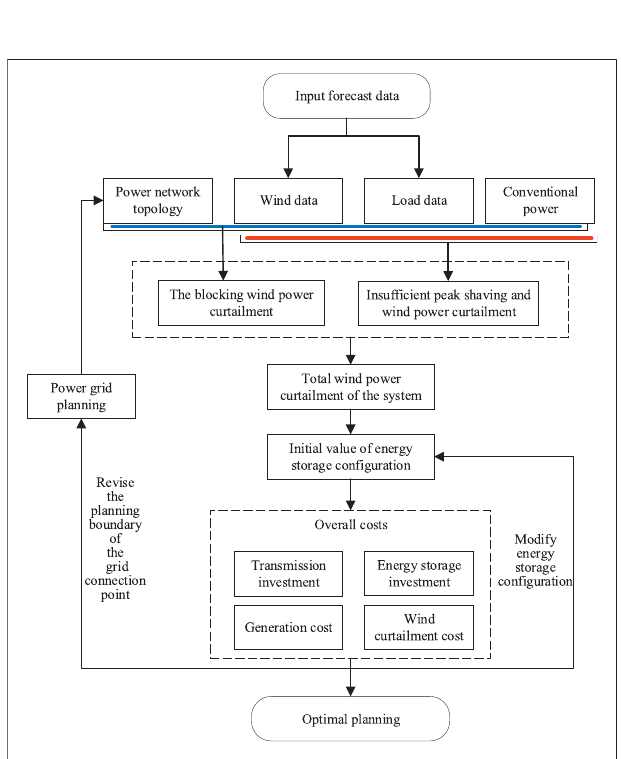
FIGURE 4 | Principles of storage-transmission joint